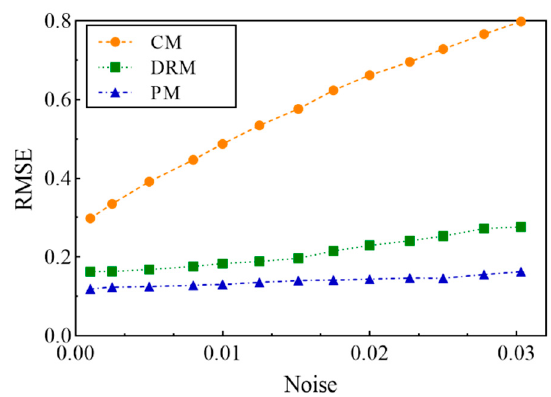
Figure 5. The root mean square error (RMSE) of reconstructed conductivity using the conventional method (CM), double regularization method (DRM), and the proposed method (PM).